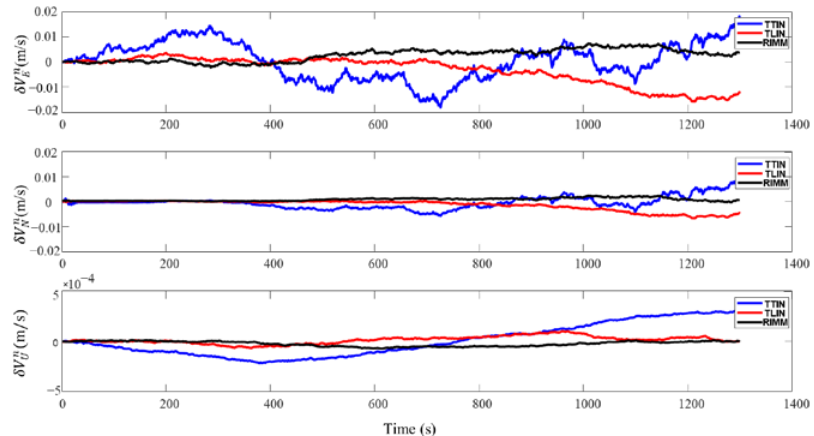
Figure 7. Velocity errors of three algorithms when DVL working p roperly. Table 2. Velocity error parameters for the three algorithms when DVL w orking p roperly.